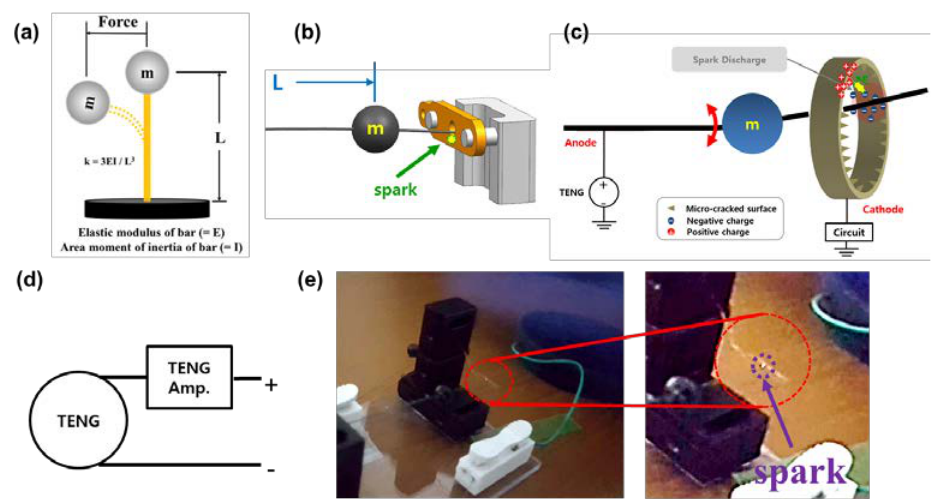
Figure 1. Basic principle of TENG output amplifier using micro plasma. ( a ) Basic vibration structure of mass and bar. ( b ) Design of vibration structure. ( c ) Working mechanism by which the charge is transferred during the process. ( d ) Schematic of circuit connection of TENG output amplifier. ( e ) Micro plasma occurring in the proposed TENG output amplifier.